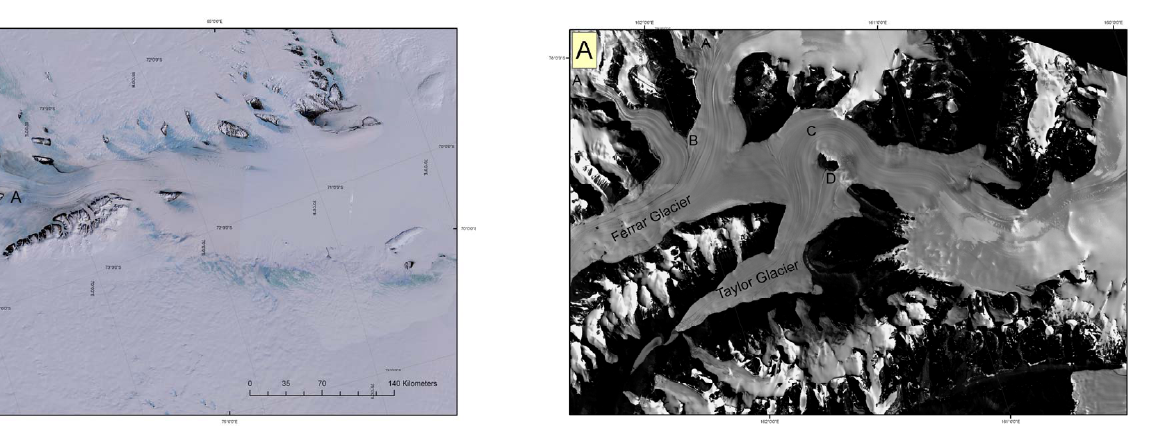
Figure 2A. Mosaic of four Landsat images from LIMA of the Lambert Glacier/Amery Ice Shelf System.